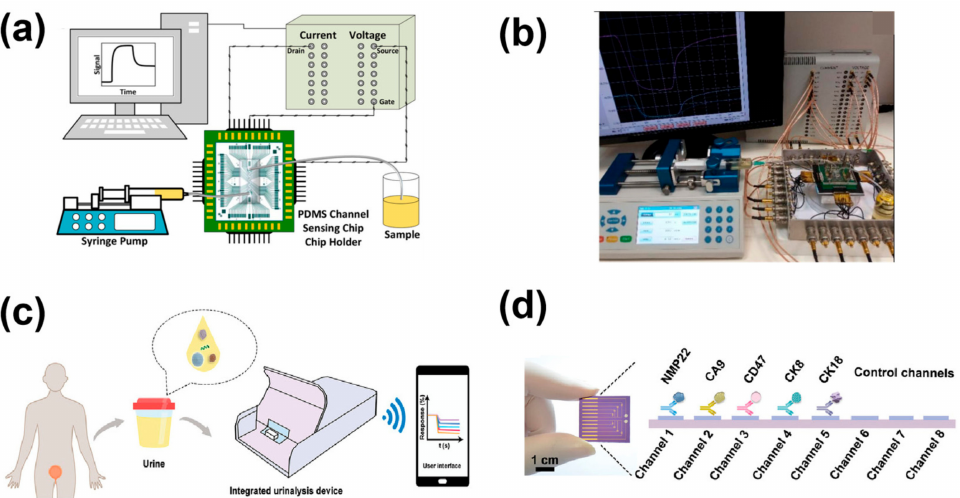
Figure 9. ( a ) Schematic diagram of the finished product after the final experiment. ( b ) A physical image of the device. ( c ) Urine sample detection device, which is connected to the Internet terminals. ( d ) Sensor surface modification sketches, including five channels for bladder cancer protein function, three channels for urine test background signal, a total of eight sensor channels. ( a ) Reproduced with permission [65]. Copyright 2020, American Chemical Society. ( b ) Reproduced with permission [65]. Copyright 2020, American Chemical Society. ( c ) Reproduced with permission [67]. Copyright 2022, John Wiley and Sons. ( d ) Reproduced with permission [67]. Copyright 2022, John Wiley and